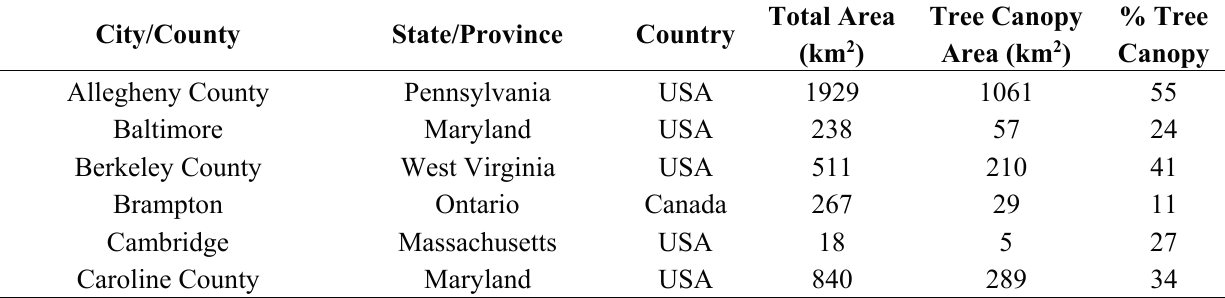
Table 1. Tree Canopy (UTC) assessments conducted for selected cities and counties in the United States and Canada, with total area of each study area (km 2 ), area of mapped tree canopy (km 2 ), and tree canopy as a percentage of total area